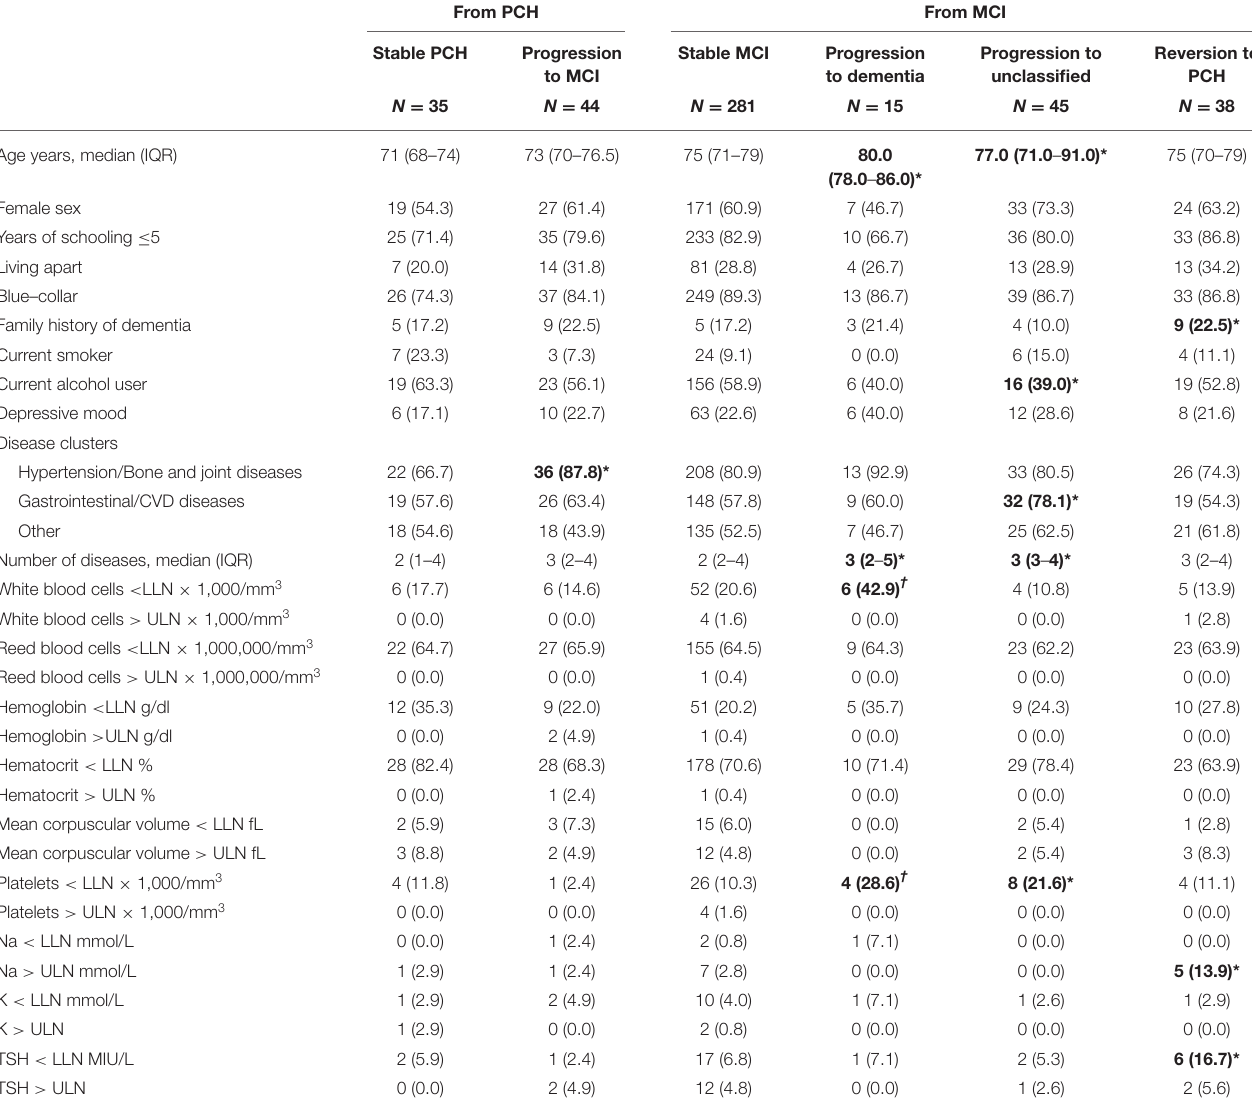
TABLE 2 | Participants’ characteristics by cognitive progression or reversion.